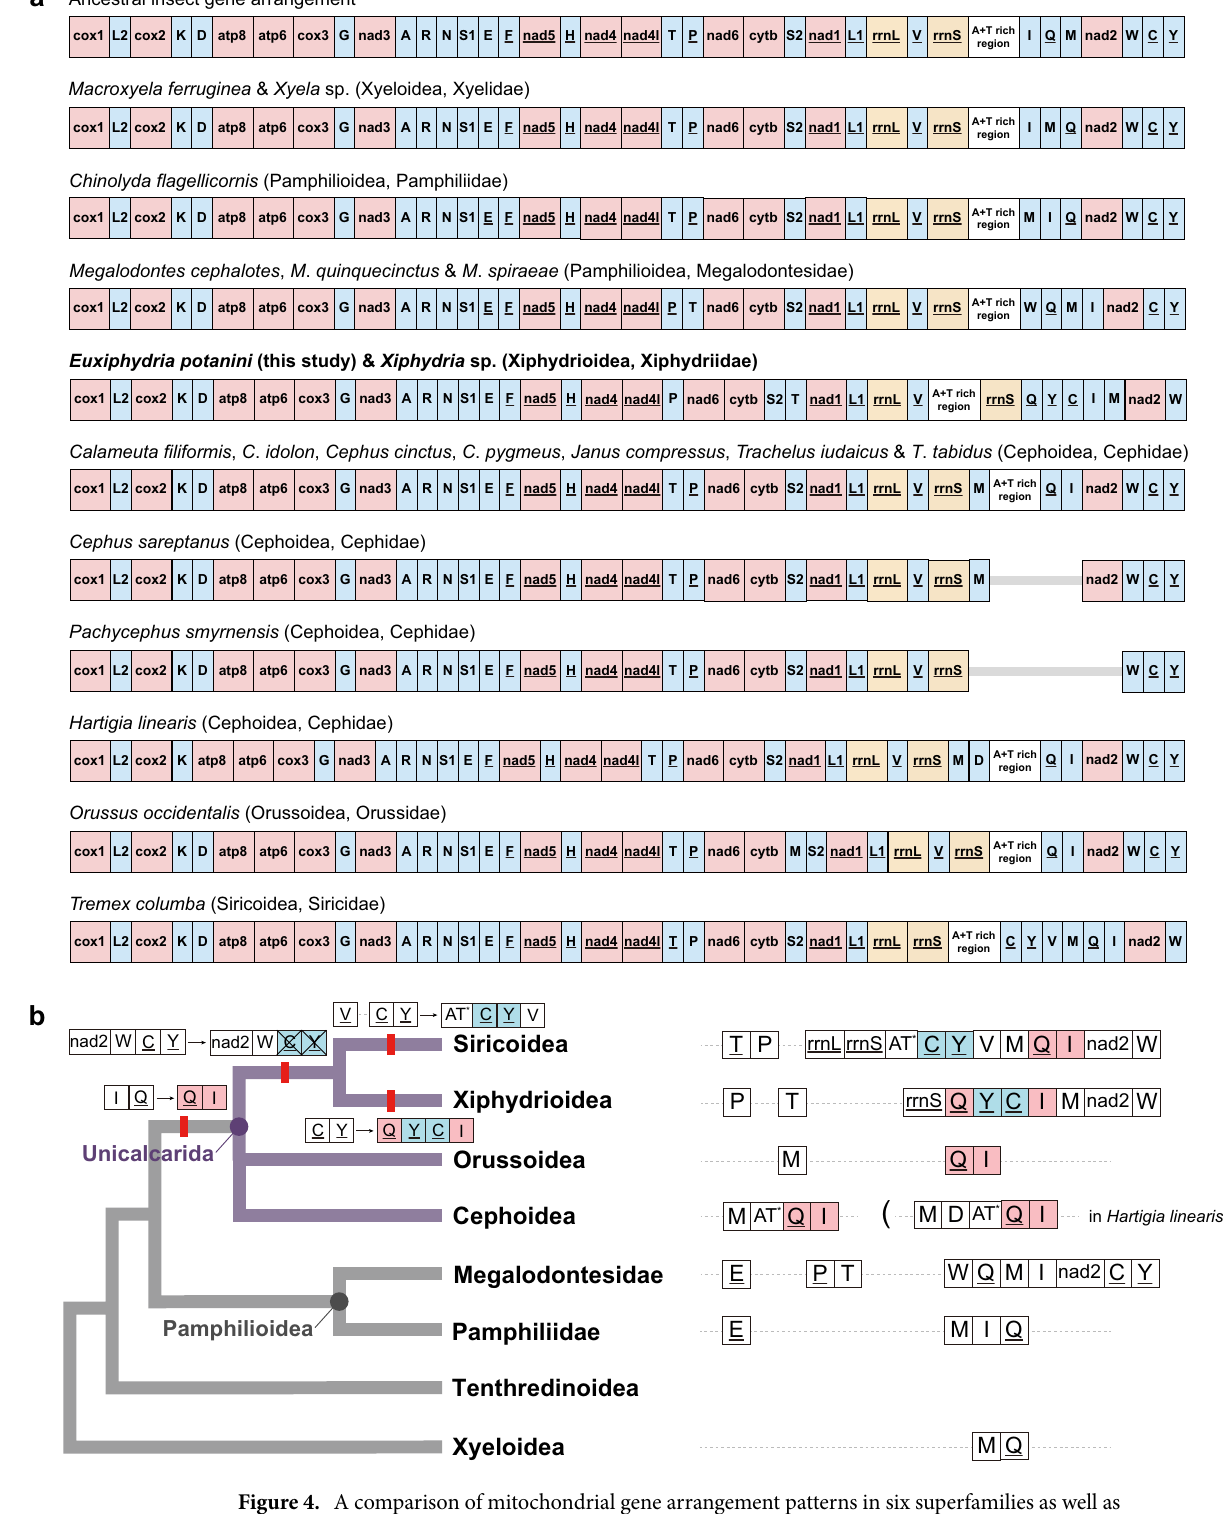
Figure 4. A comparison of mitochondrial gene arrangement patterns in six superfamilies as well as mitochondrial gene rearrangement during unicalcarid evolution: ( a ) Comparison of mitochondrial gene arrangement patterns of twenty sawflies in six superfamilies with an ancestral insect form; ( b ) Mitochondrial gene rearrangement during the unicalcarid evolution. Some mitochondrial gene rearrangements are shown on the symphytan phylogenetic tree, which may indicate possible synapomorphic characters supporting the monophyly of Unicalcarida (QI), the close relationship of Xiphydrioidea and Siricoidea (CY translocations), and the monophyly of Xiphydrioidea (YC between Q and I). The translocation and inversion of V occurred only in the lineage of Siricoidea. Asterisks indicate the A + T rich